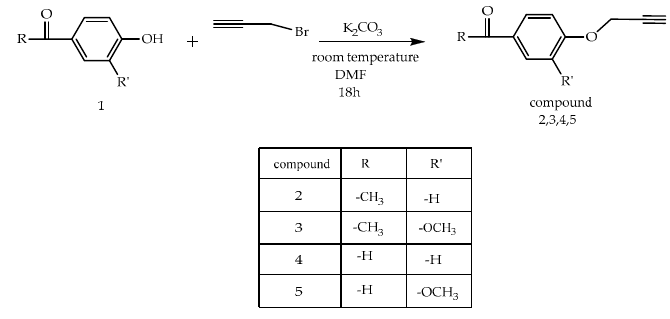
Figure 1. Potential pharmaceuticals based on 1,2,3-triazoles.